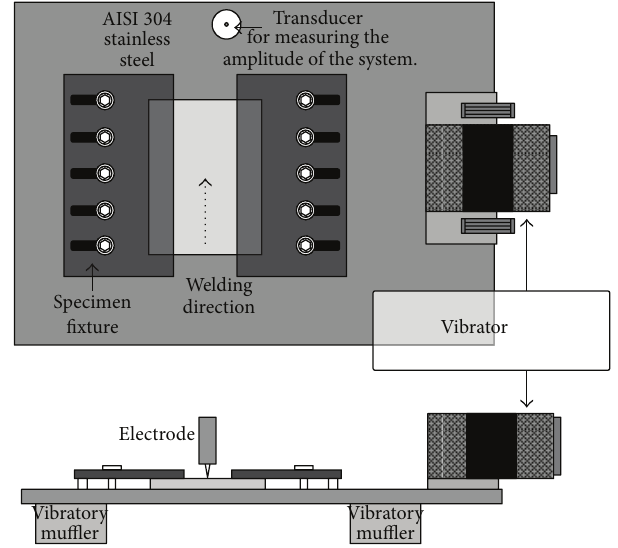
Figure 1: The simultaneous vibration welding system.